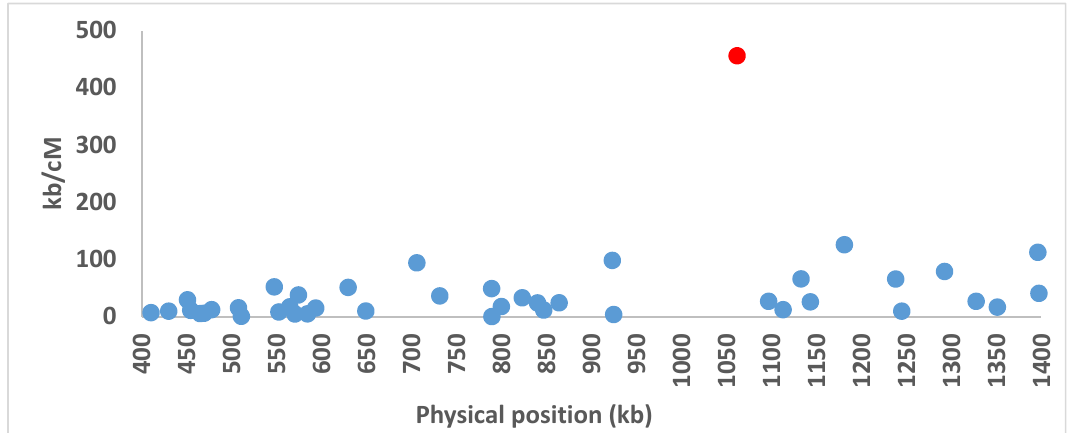
Figure 10. Genetic to physical distance plot for adjacent markers for a 1 MB genomic region on chromosome 1 of A. bisporus var. burnettii strain 119/9. The red dot indicates the position of the marker pair flanking the HD genes on chromosome 1.